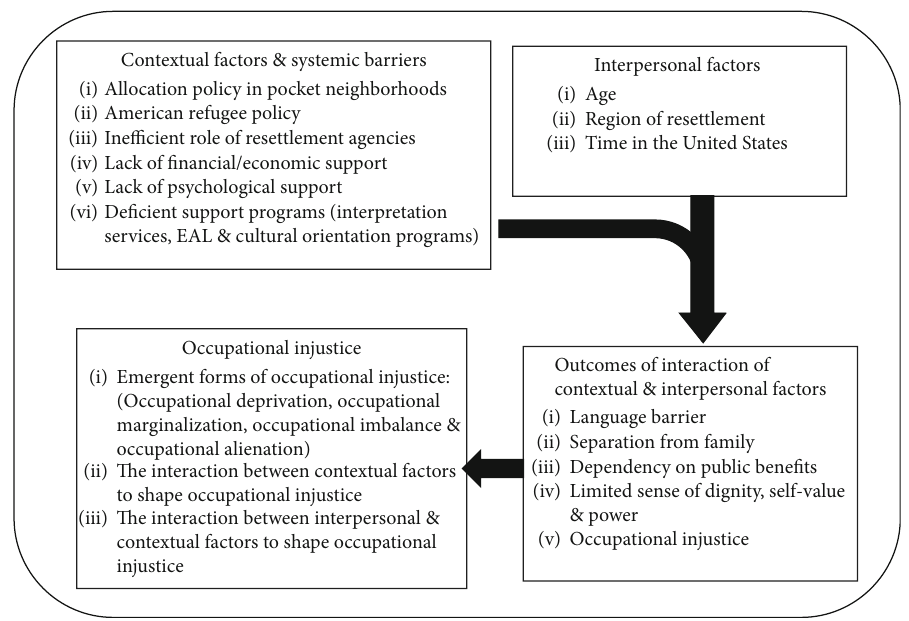
Figure 3: The code system contemplated throughout the IPA. Core themes are